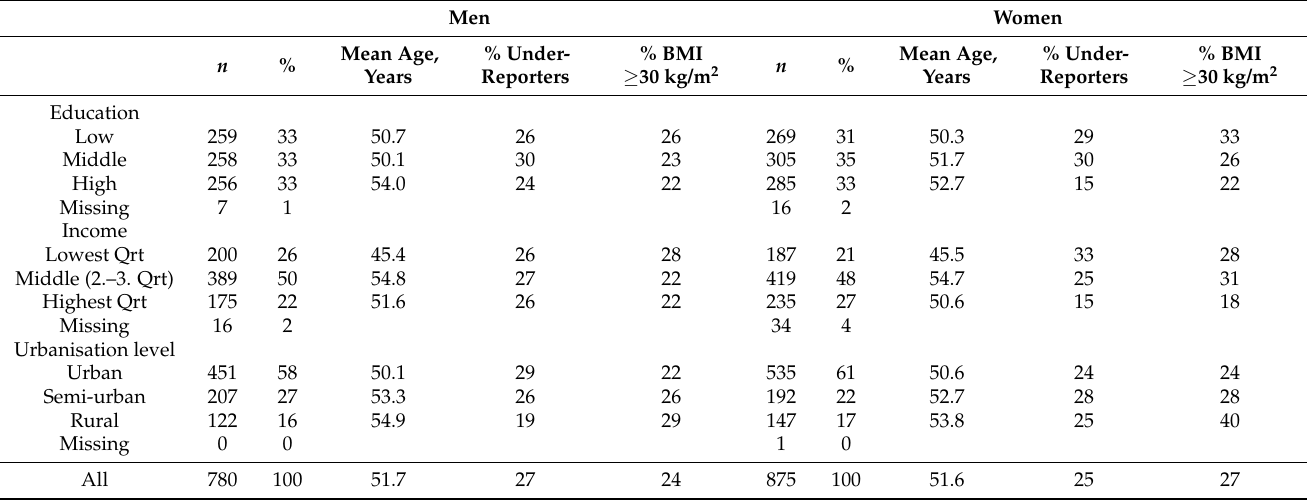
Table 1. The participants of the FinDiet 2017 Survey by gender, education, income and urbanisation